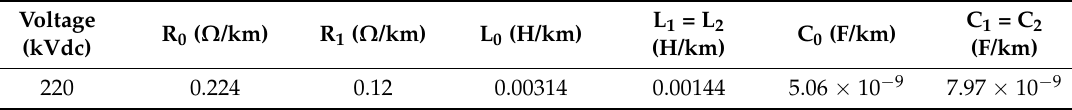
Figure 9. Model for analysis of the circulations of ground fault currents in shields of power cables. The parameters of the overhead line are presented in Table 4. Table 4. Characteristics of 220 kV overhead line.